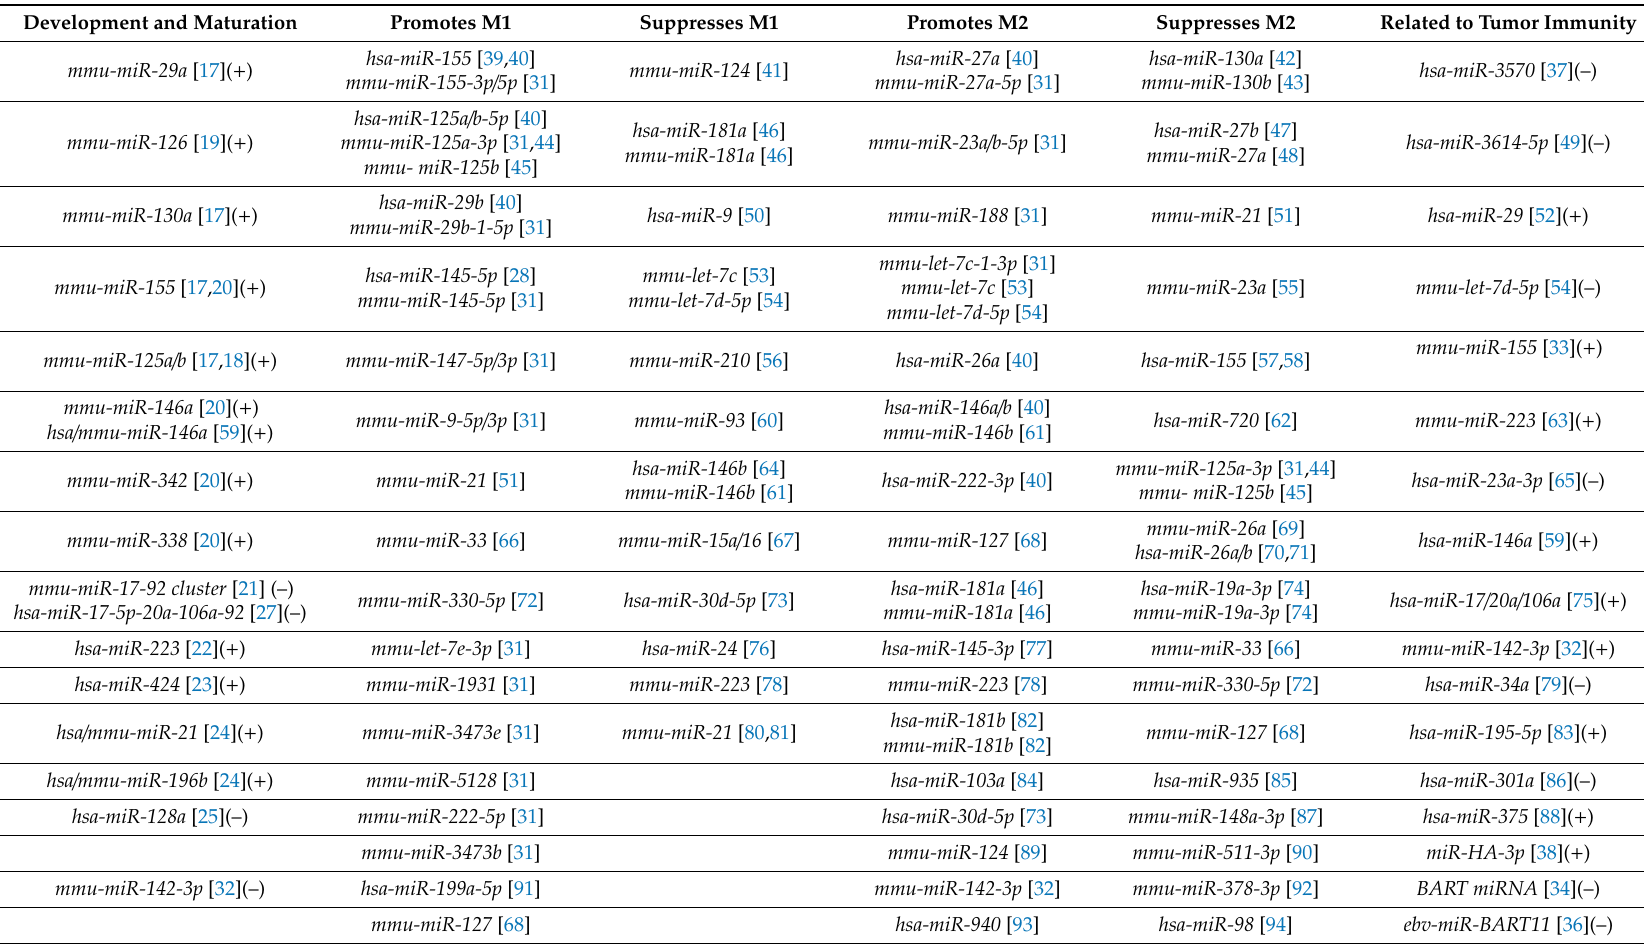
Table 1. A list of miRNAs involved in macrophage development, macrophage polarization, and tumor